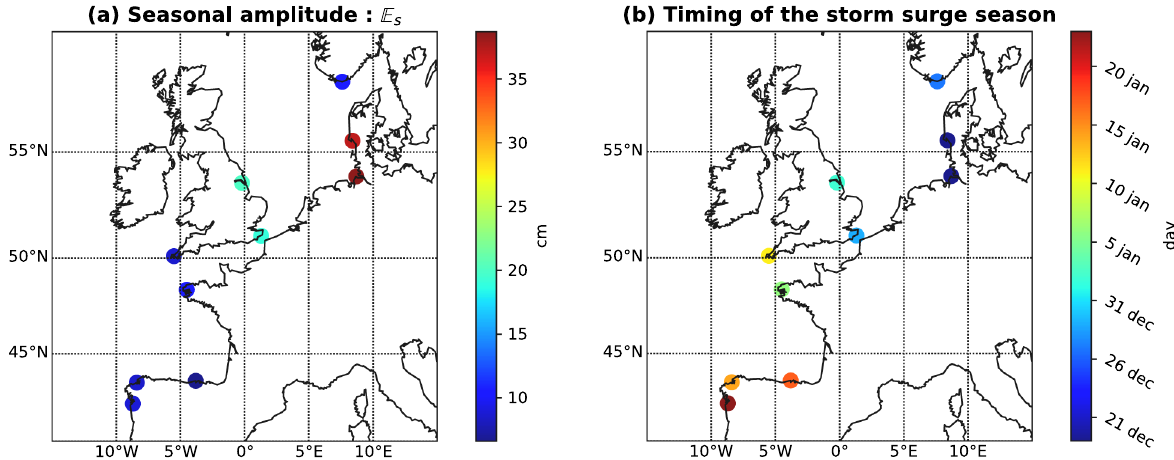
Figure 2. Characterization of the annual cycle of storm surges: ( a ) seasonal amplitude and ( b ) timing of the storm surge season. These two parameters are computed from the GEV-based model (Method